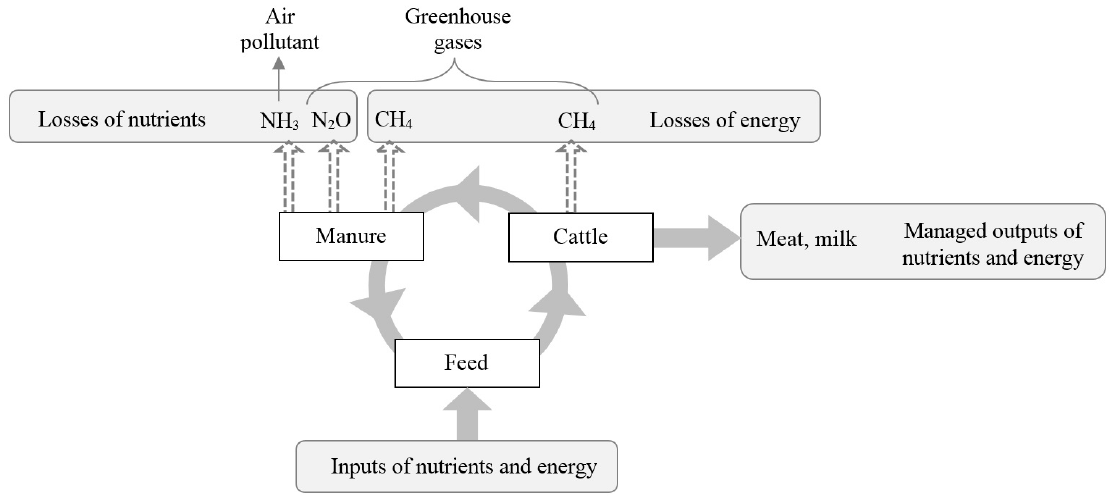
Figure 1. Gas emissions represent losses of nutrients and energy from cattle operations.